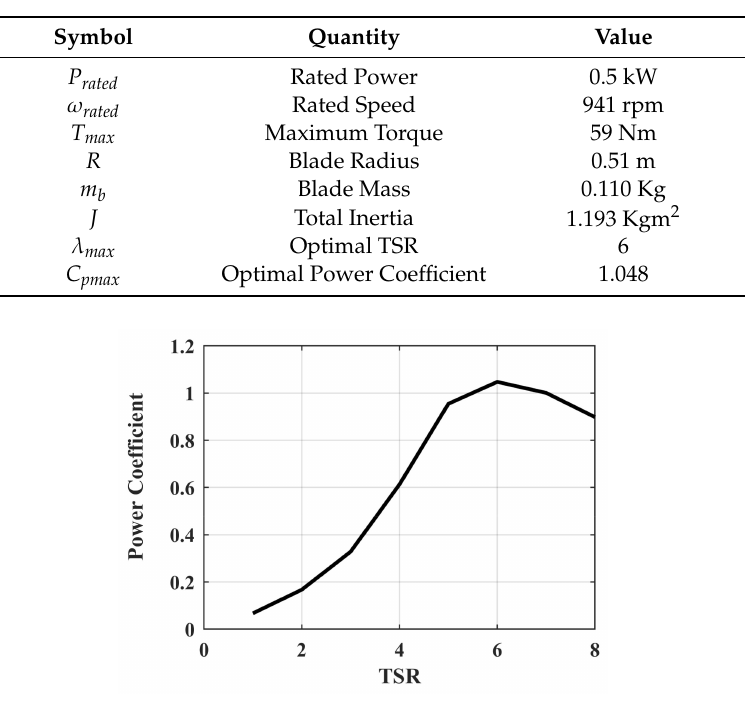
Figure 2. Rendering of the DHAWT–ABPMSG system. Table 1. Ducted wind turbine parameters.